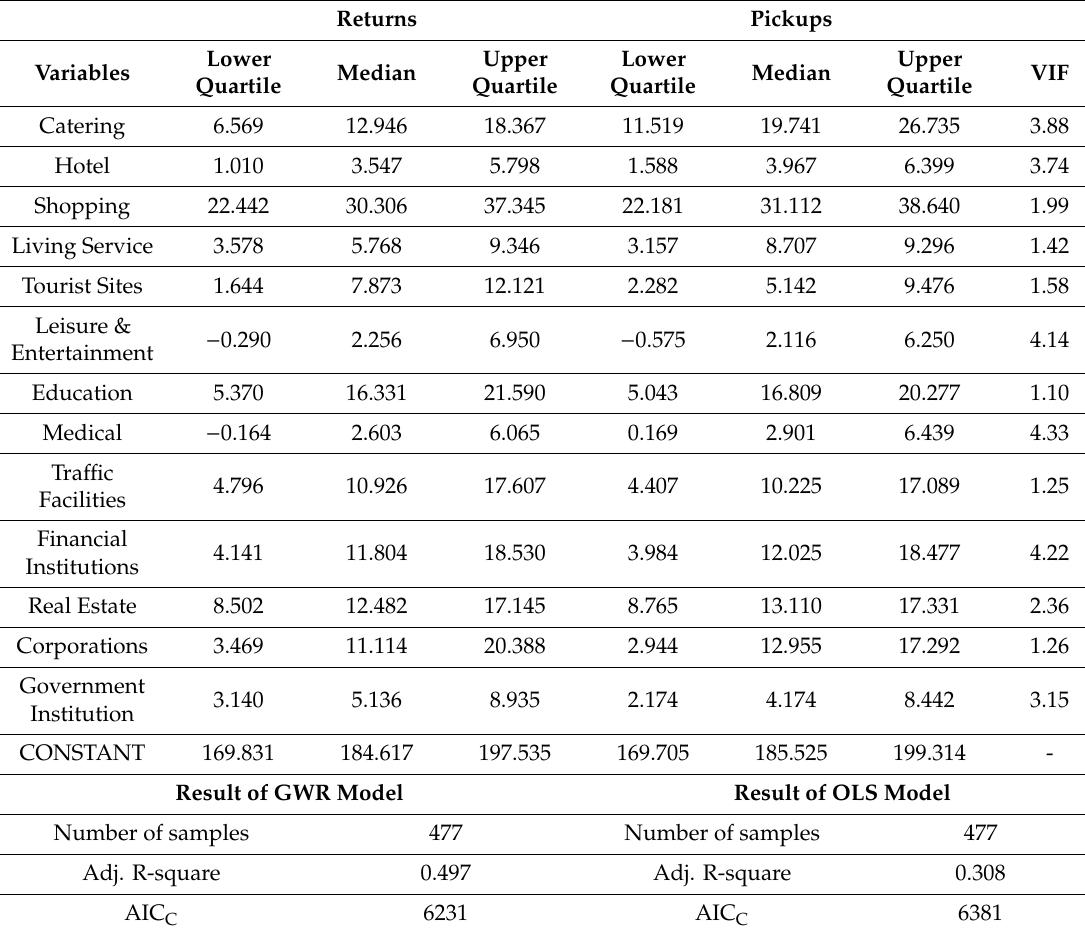
Table 2. Estimated results of the GWR